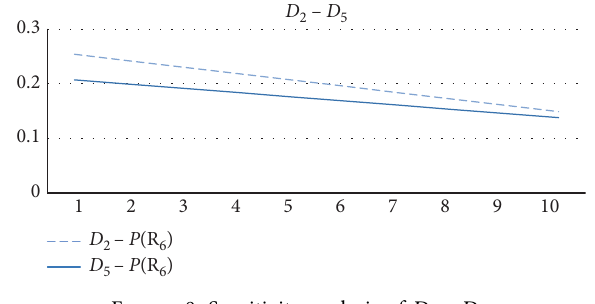
Figure 8: Sensitivity analysis of D